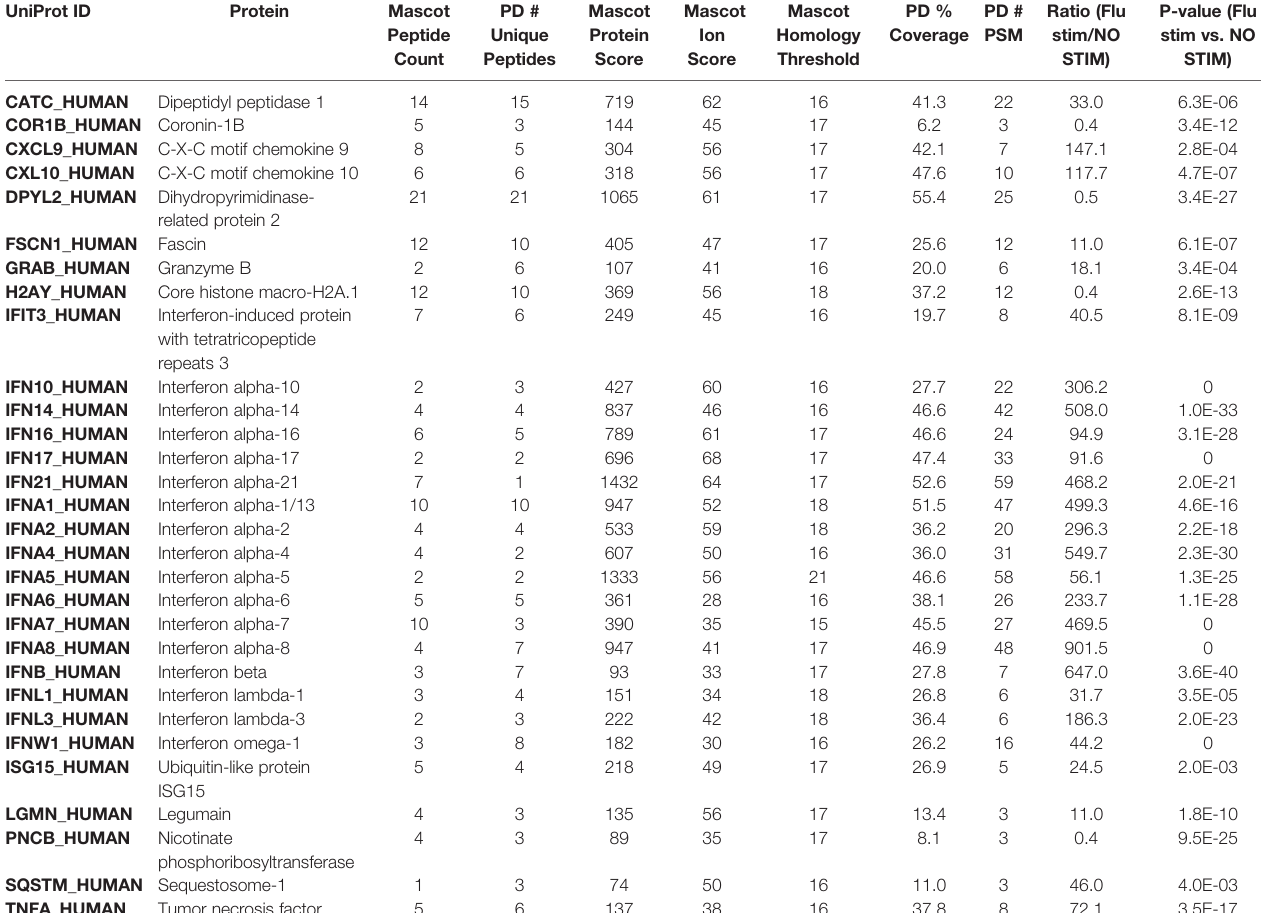
TABLE 1 | Supporting protein identi fi cation evidence for example differently expressed proteins from Figure 1 , the pDC secretome: baseline vs in fl uenza induced*. UniProt